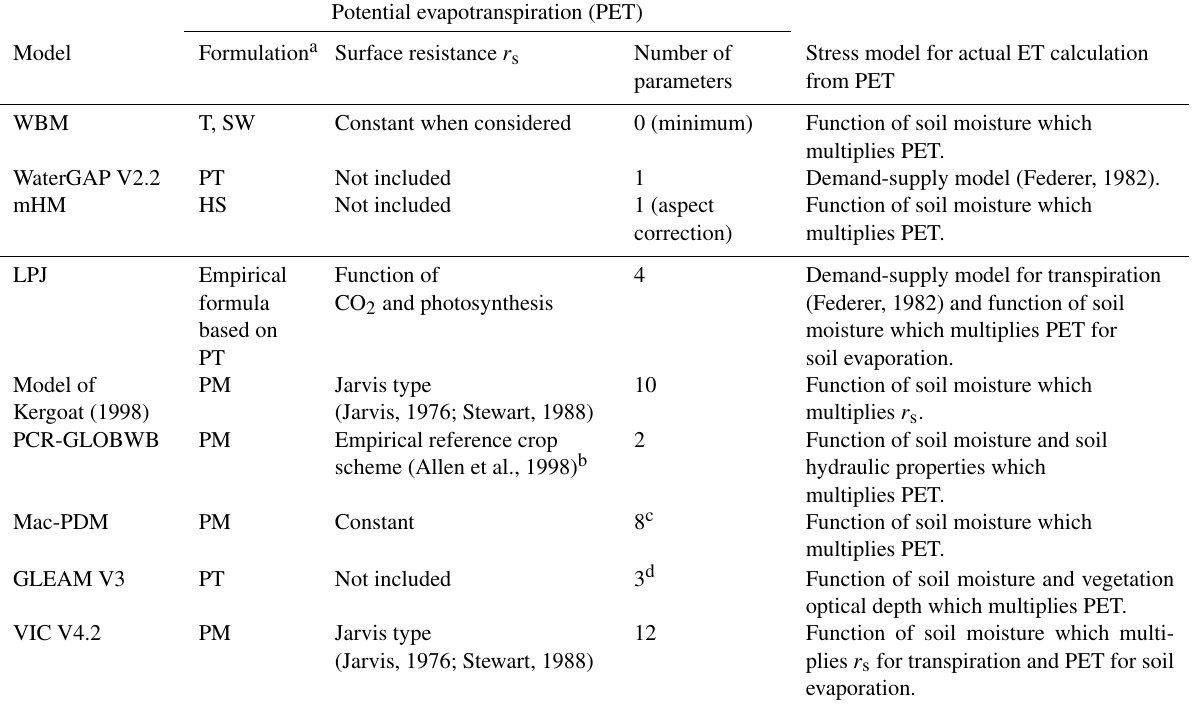
Table A2. Representation of potential evapotranspiration (PET) and stress model for actual evapotranspiration (ET) calculation from PET in the large-scale models of Table